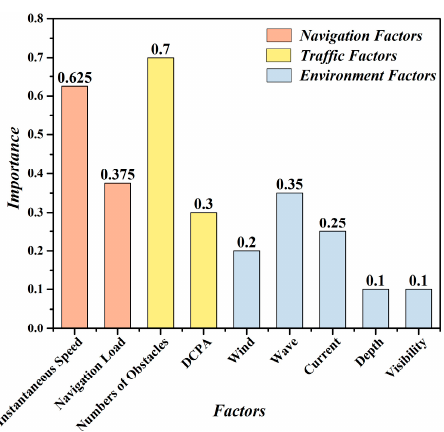
Figure 7. Factor importance in the different subsets.